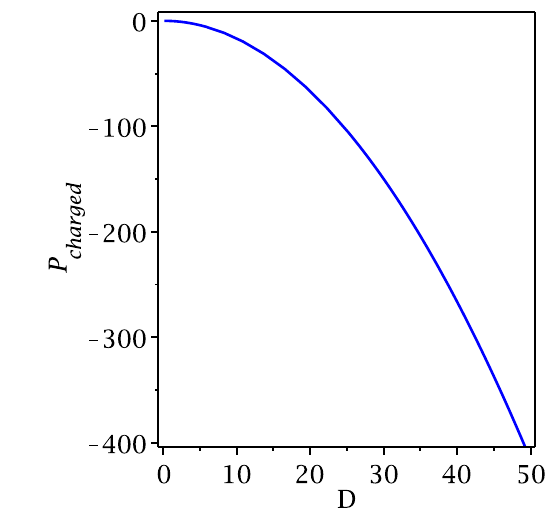
Fig. 13 The line pressure P charged vs radius D . We have chosen m 0 = − 80, L (ε) = 1 . 1, H (ε) = 1 . 1, σ q = 1, and l = 1 4.1 Equation of state of thin-shell gravastars in gravity’s